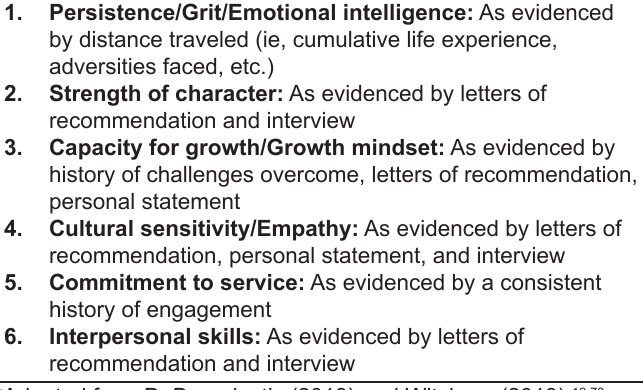
Figure 2. Qualities and characteristics to consider during holistic review.*